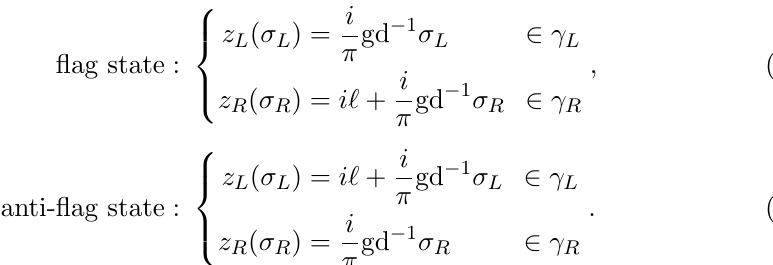
Figure 8 . The region R and the left and right parameterized curves (cid:13) L and (cid:13) R characterizing the (cid:13)ag state j 1) and anti-(cid:13)ag state (1 j . parameterized according